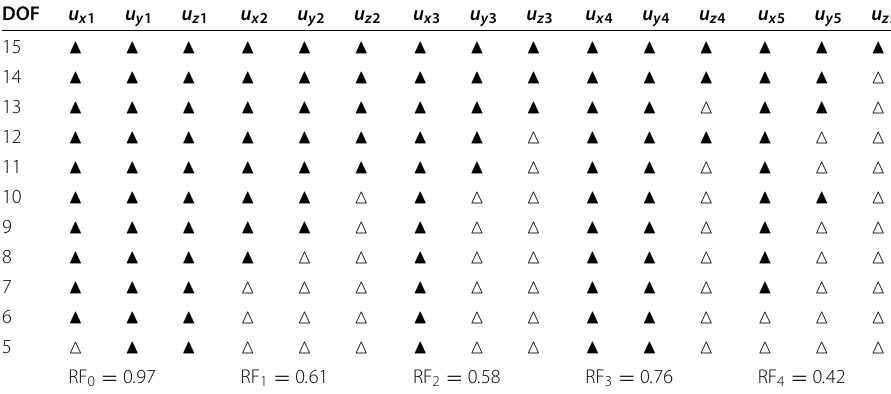
Table15 BTD models for 0/90/0/90, R/a = 5 , a/h = 5 ,